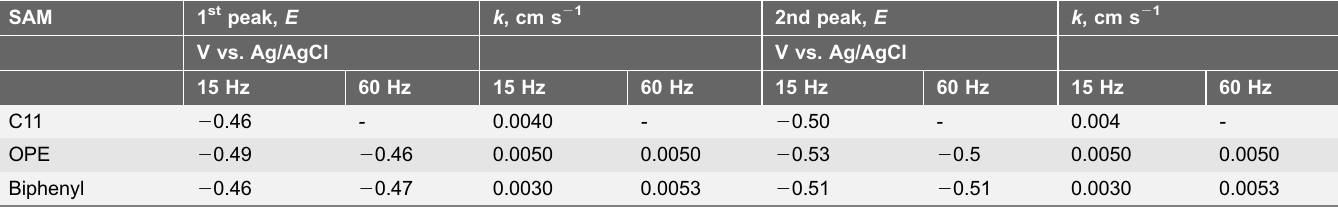
Table 3. Electrochemical simulation output a .